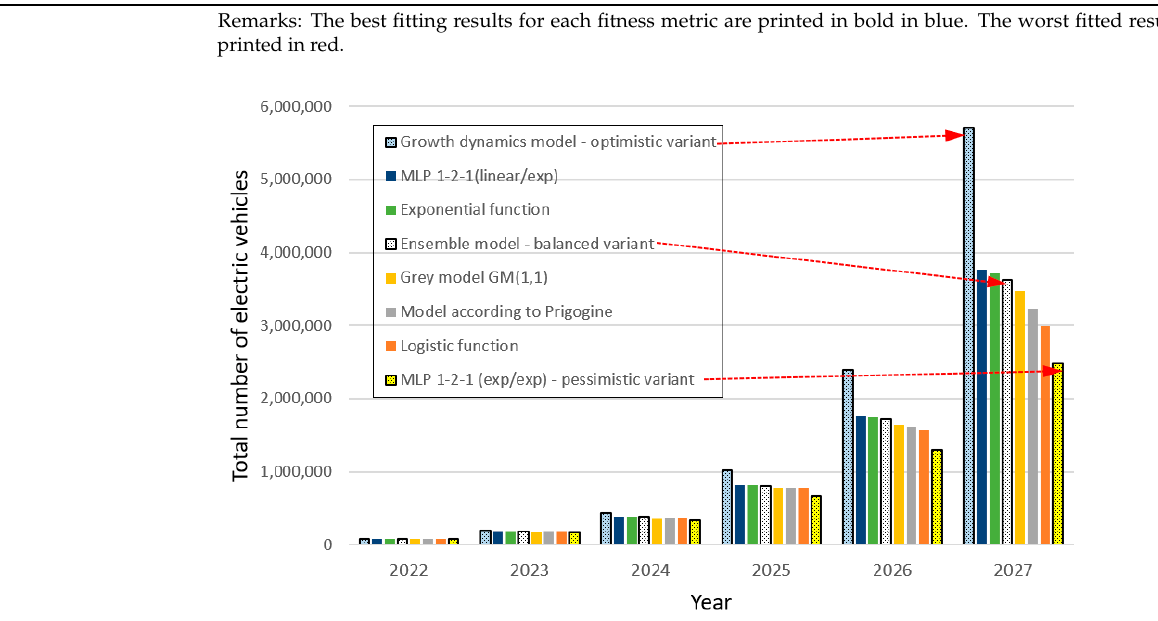
Figure 7. Results of forecasts of the total number of EV in Poland from 2022 to 2027 obtained by eight